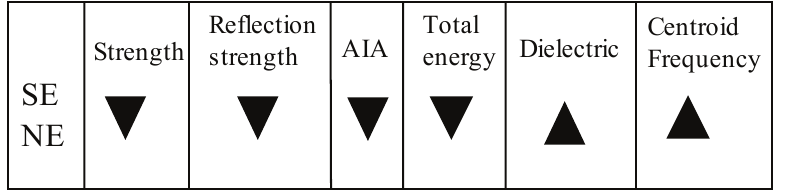
Figure 9. Summary of relative attributes and properties, where arrow widens toward the larger